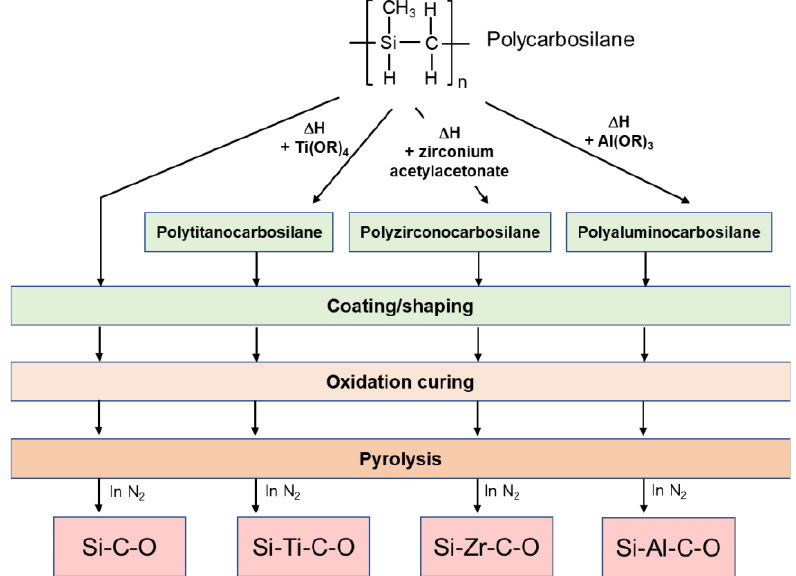
Figure 8. Typical preparation process of metal-containing SiC ceramics derived from polymetallocarbosilane (Ti, Zr, and Al) precursors (with the pure PCS precursor for comparison) [77] .